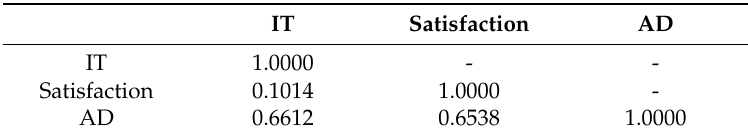
Table 5. Pairwise correlations ( n = 200).